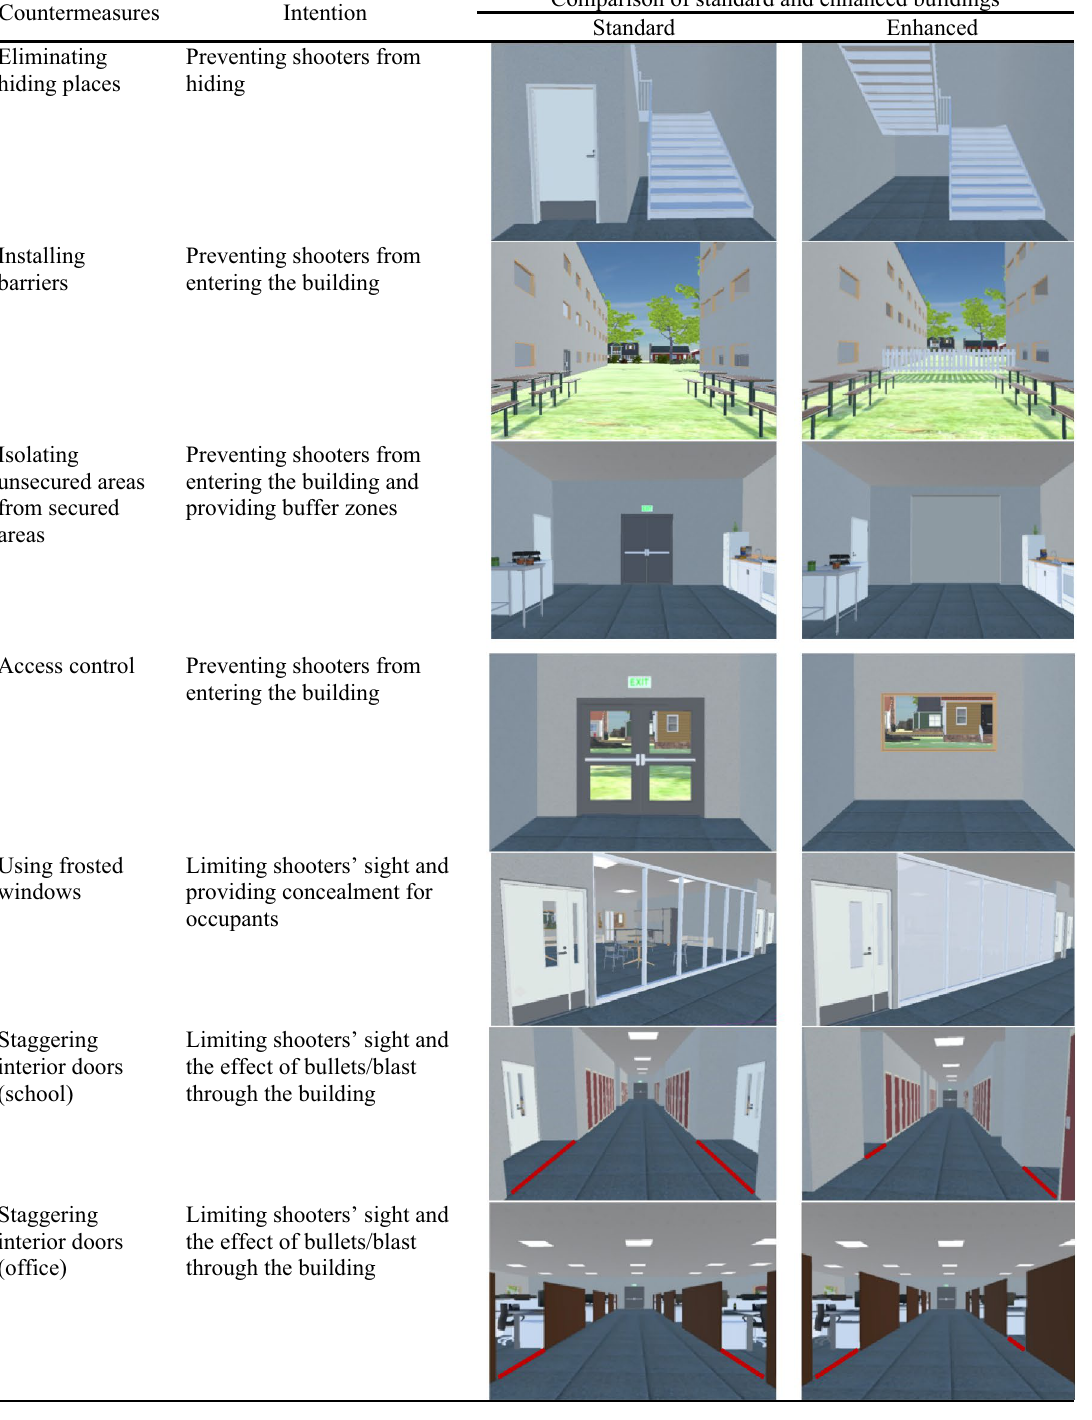
Table 1. Security countermeasures included in the virtual